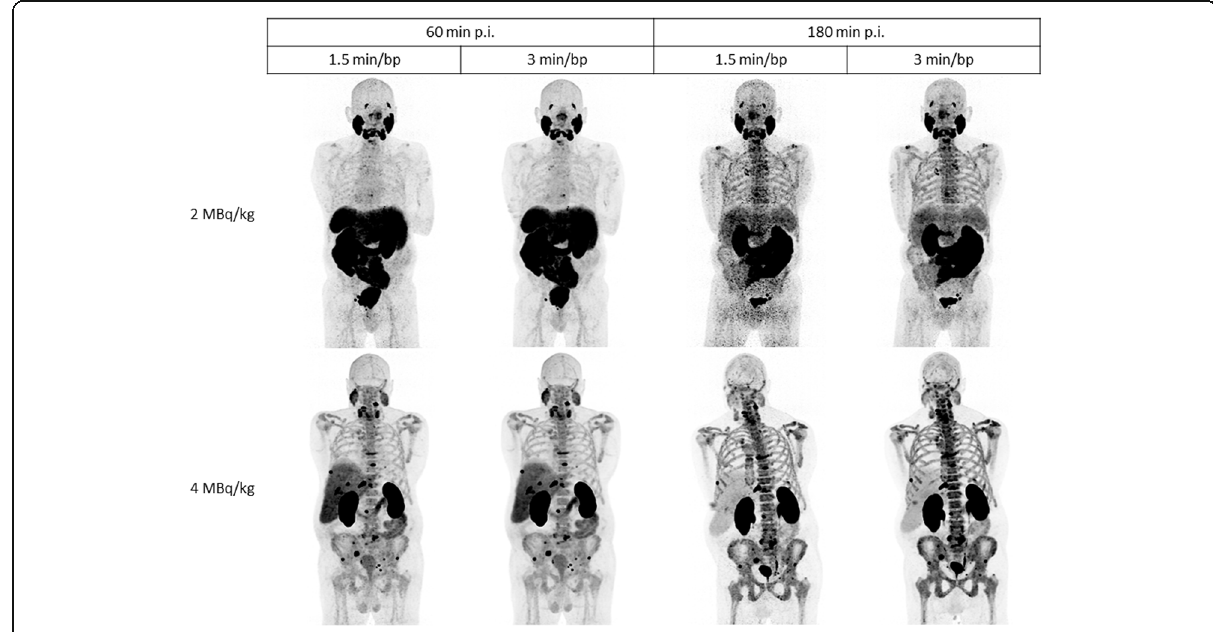
Fig. 3 MIP images of patients NGP2-6 (2 MBq/kg, top) and NGP2-4 (4 MBq/kg, bottom). NGP2- x = patient